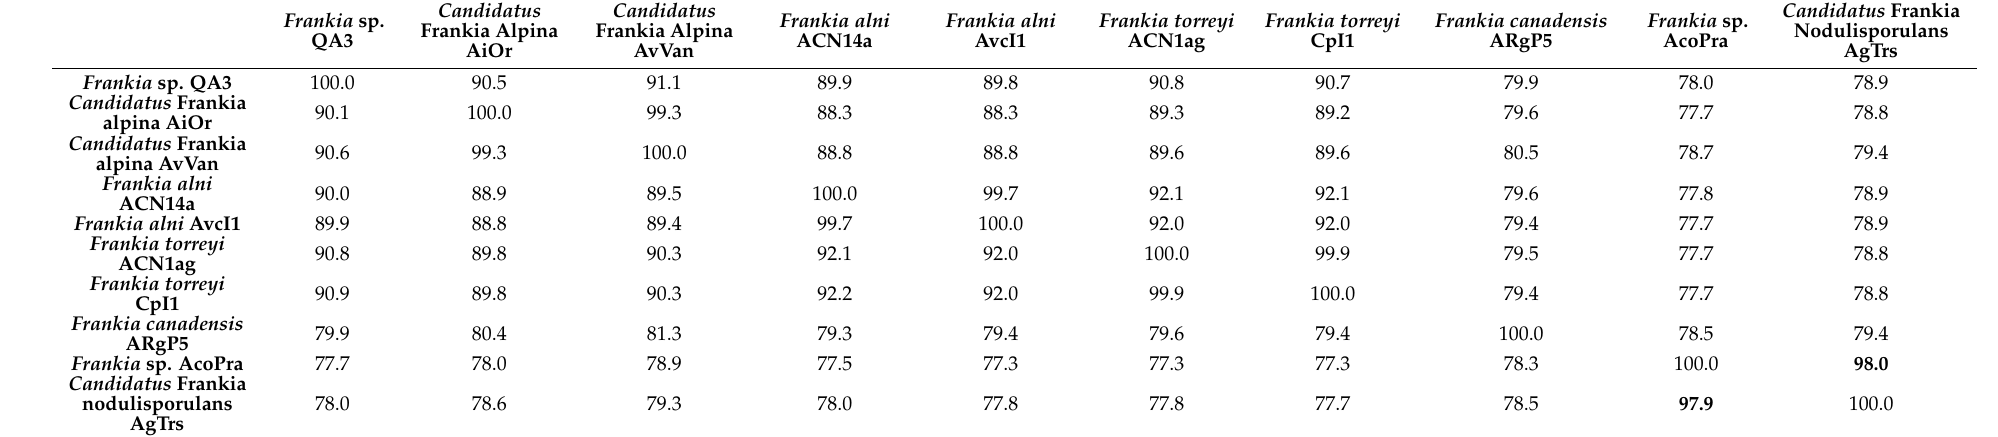
Table 2. Median ANI values between AcoPra and other Alnus -infective Frankia species in Cluster